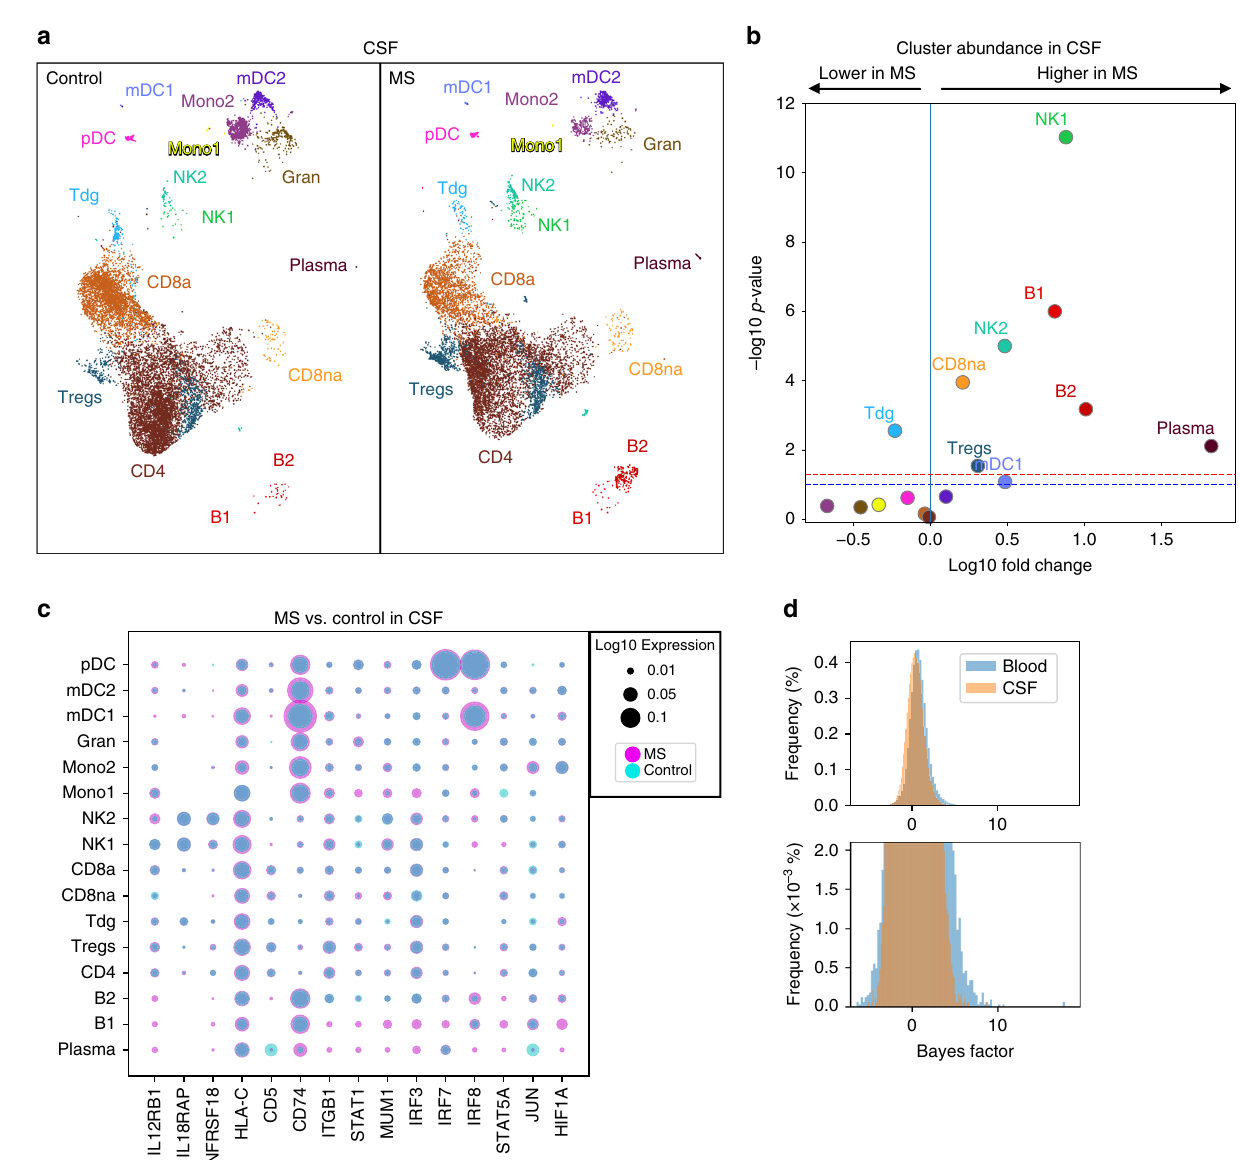
Fig. 2 MS predominantly alters CSF cell composition and blood cell transcription. a Comparative UMAP plots depicting only CSF cells from control (12,705 cells, left plot) and MS (9652 cells, right plot) donors. Color coding and cluster names are as in Fig. 1. b Volcano plot showing differences of cluster abundance of only CSF cells in MS samples compared to controls plotted as fold change (log10) against p value ( − log10) based on beta-binomial regression. c Dotplot depicting selected genes differentially expressed in at least one cluster of MS cells compared to controls in CSF. Dot size encodes percentage of cells expressing the gene. Purple indicates higher, and turquoise indicates lower expression in MS, respectively. d Bayes factor (BF) frequency histogram in all cluster-speci fi c case-control differential expression analyses colored by tissue. Higher magni fi cation in bottom panel. Only clusters with a minimum of ten cells per tissue per disease state are included. Please note that the BF is proportional to the likelihood of differential expression (i.e., higher BF indicates more likely DE) 28 . Source data for ( b , c ) listing the differential expression values for MS vs. controls in CSF are provided in Supplementary Dataset 5. Source data for ( d ) listing the BFs for CSF vs. blood are provided in Supplementary Dataset